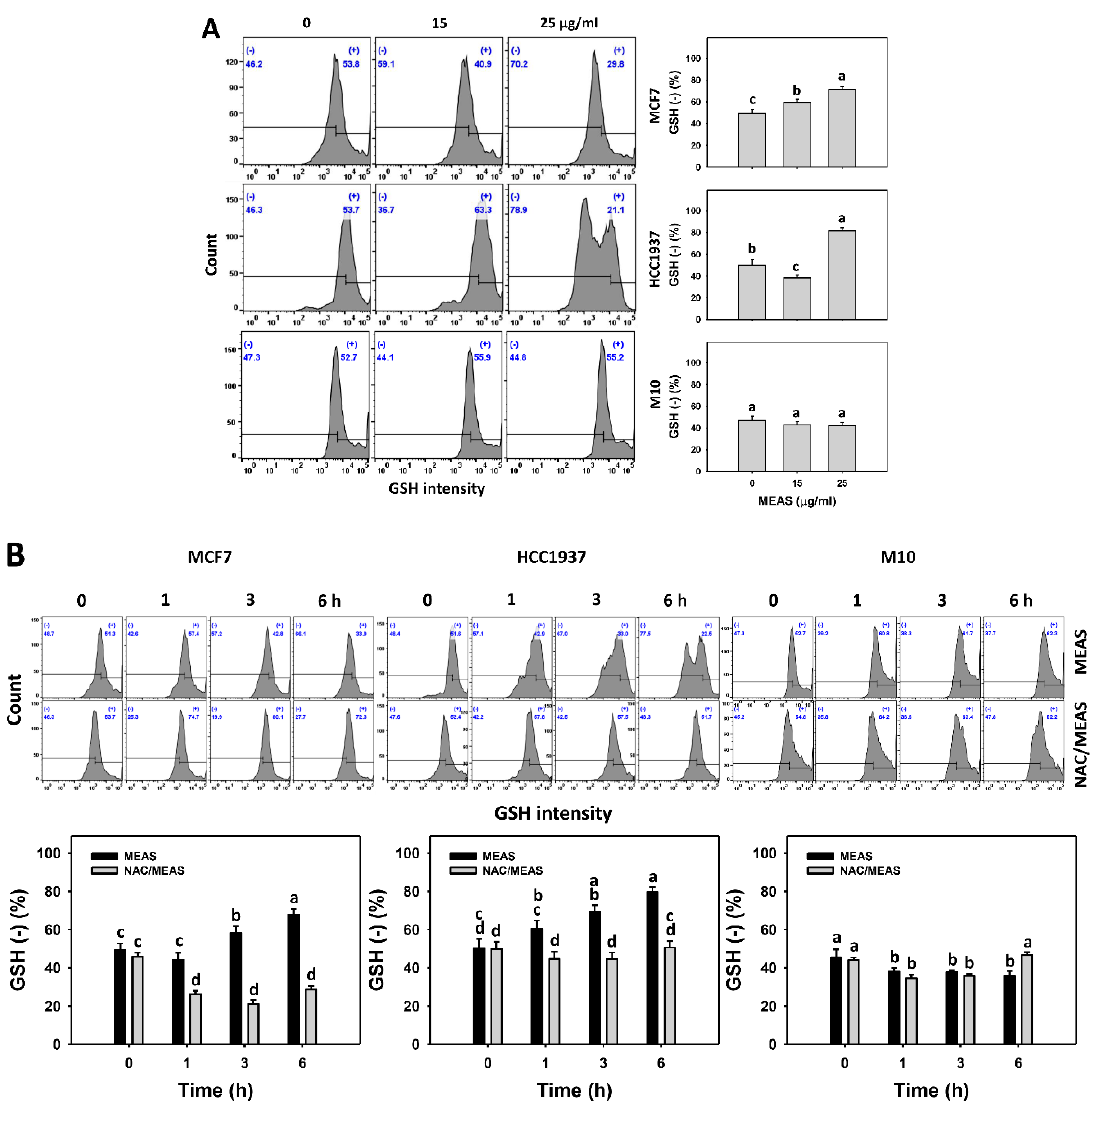
Figure 8. MEAS increased GSH (−) intensities of breast cancer cells. ( A ) GSH assay of MEAS. Except for normal breast cells (M10), others were TNBC and non-TNBC cells. Flow cytometry was performed after 6 h drug treatment. (−) , inserted within each panel, indicates the GSH (−) intensity. ( B ) GSH assay of NAC/MEAS. NAC/MEAS represents NAC pretreatment (10 mM, 1 h) and MEAS posttreatment for 0, 1, 3, and 6 h. Data = mean ± SD ( n = 3). Statistical software assigned low-case letters to each treatment.